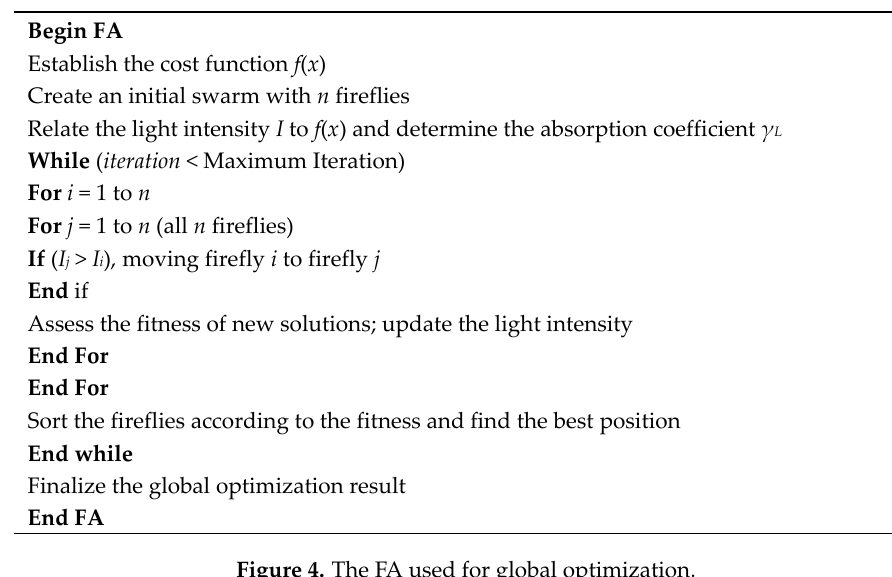
Figure 4. The FA used for global optimization.